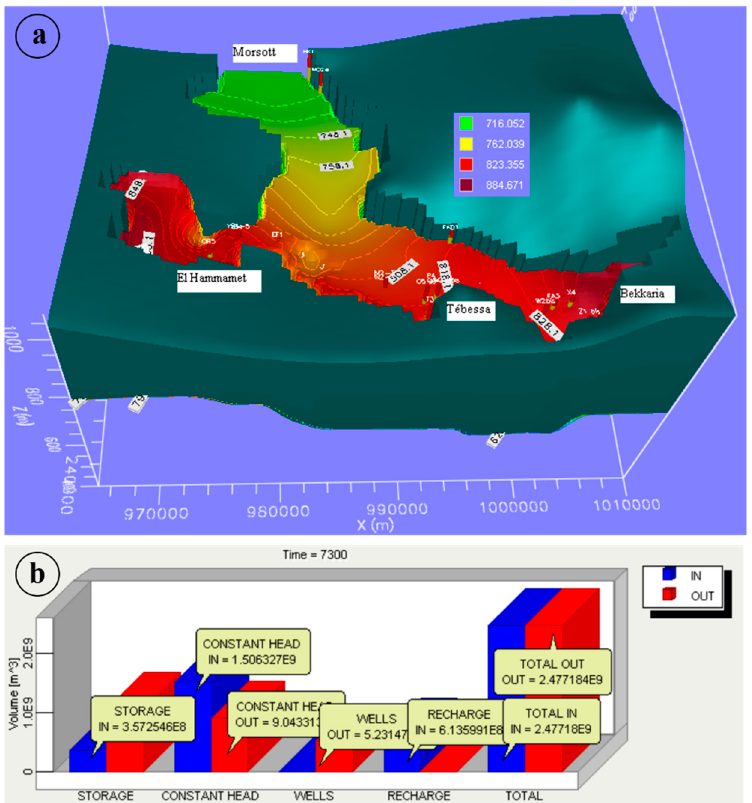
Figure 7. ( a ) Groundwater flow map for transient simulation in the case of the first scenario. ( b ) Water budgets for transient simulation in the case of the first scenario.